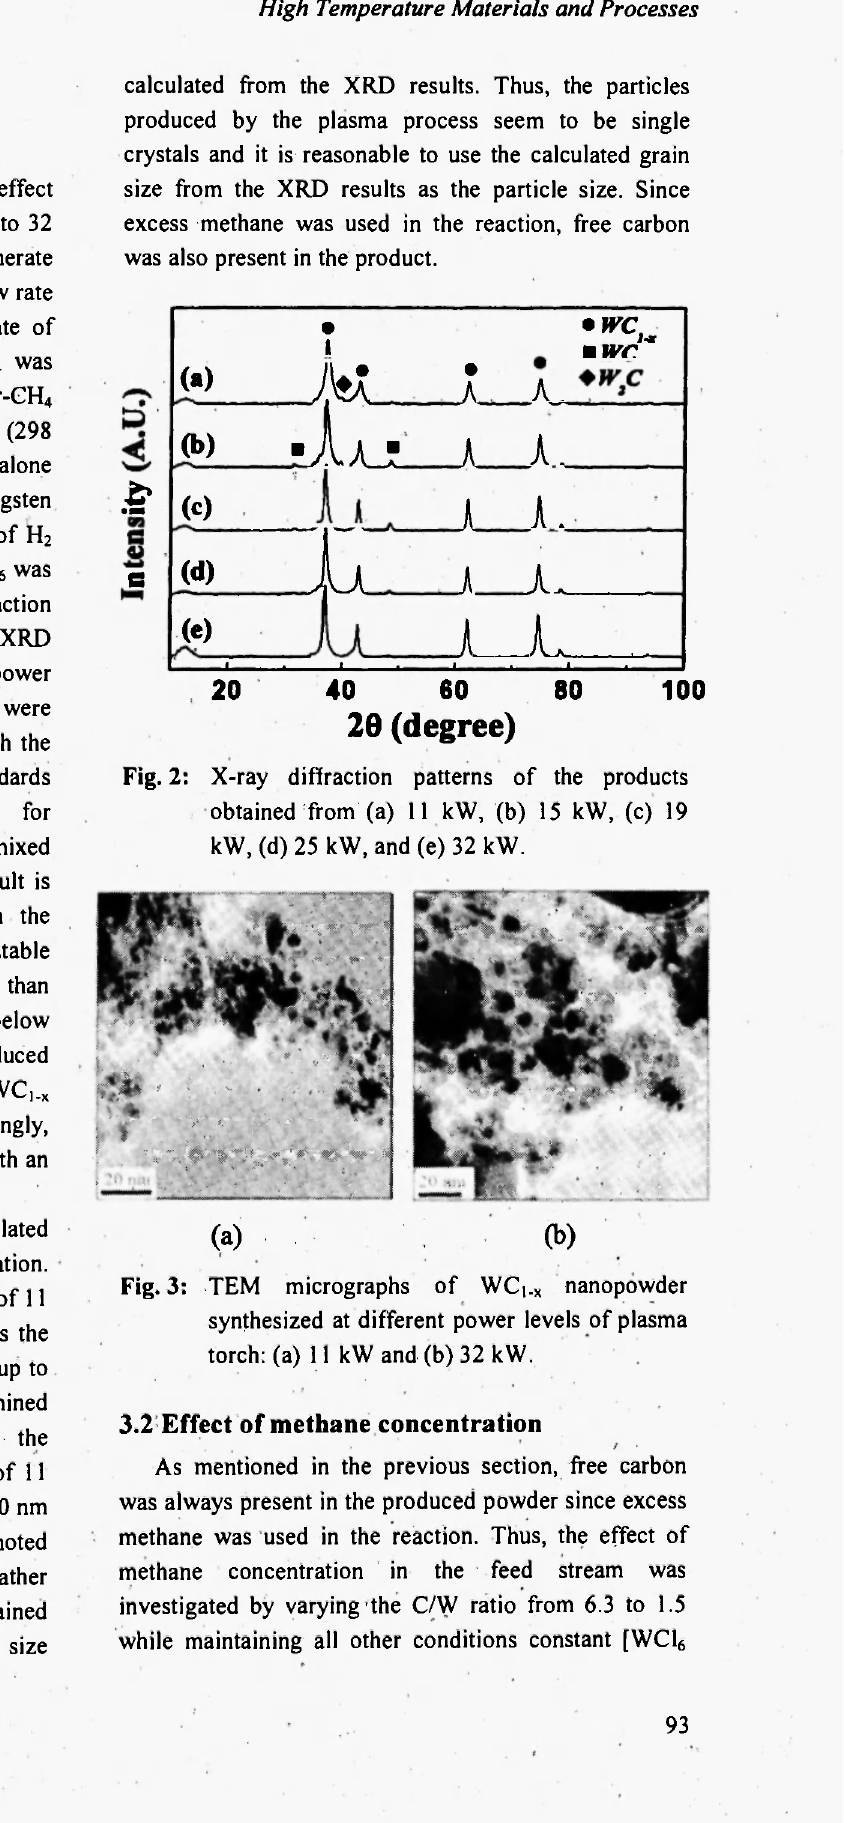
Fig. 2: X-ray diffraction patterns of the products obtained from (a) II kW, (b) 15 kW, (c) 19 kW, (d) 25 kW, and (e) 32 kW.